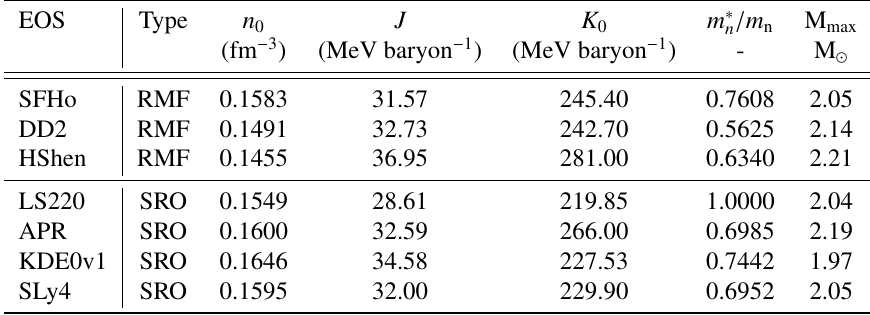
Table 1. The di ff erent columns represent the nuclear saturation density ( n 0 ) the symmetry energy at saturation density ( J ), the nuclear incompressibility ( K 0 ), the nucleon e ff ective mass ( m ∗ n ) and the maximum mass of a neutron star (M max ). The first four equations of state are calculated using RMF theory, while the last three were generated using the SRO code from